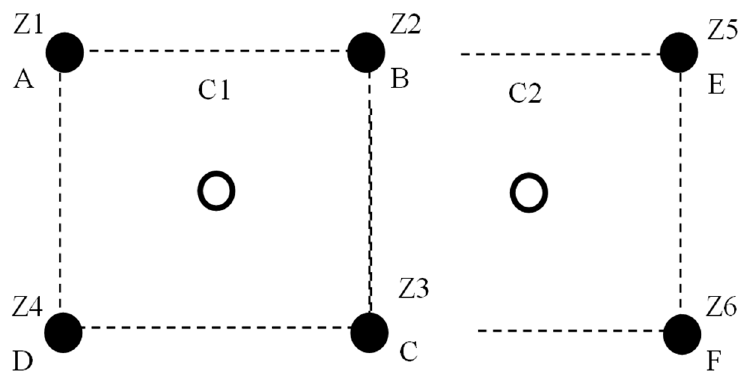
Figure 1. Schematic diagram of the micro-balance calculation principle of the injection unit.